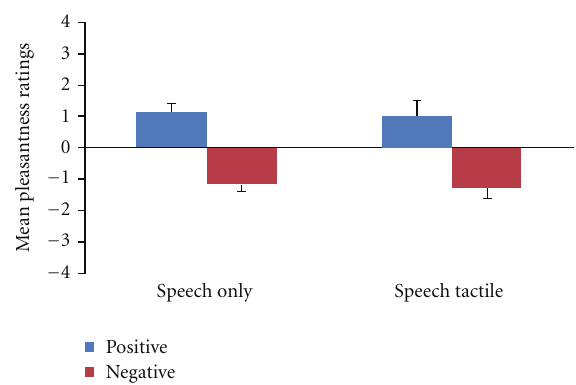
Figure 3: Means and SEMs for the ratings of the pleasantness of the stimuli by the emotional content of the speech sample and the stimulus presentation